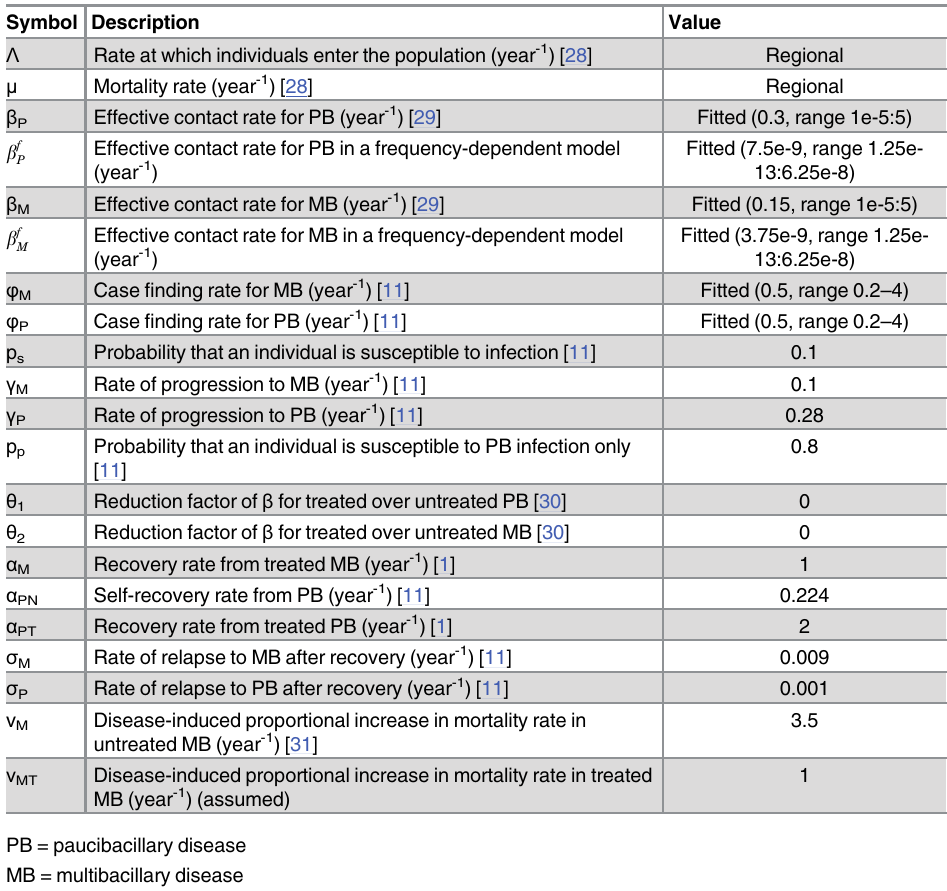
Table 1. Starting parameter values and ranges for a compartmental model of Hansen ’ s Disease. Regional values are set based on the demographics of the area providing observed data for fitting. Fitted val- ues (unfitted assumption in parentheses) are estimated using Approximate Bayesian